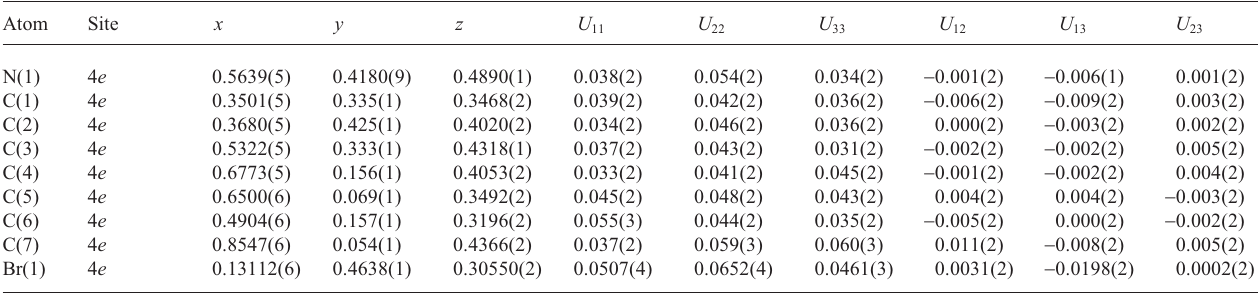
Table 3. Atomic coordinates and displacement parameters (in Å 2 )